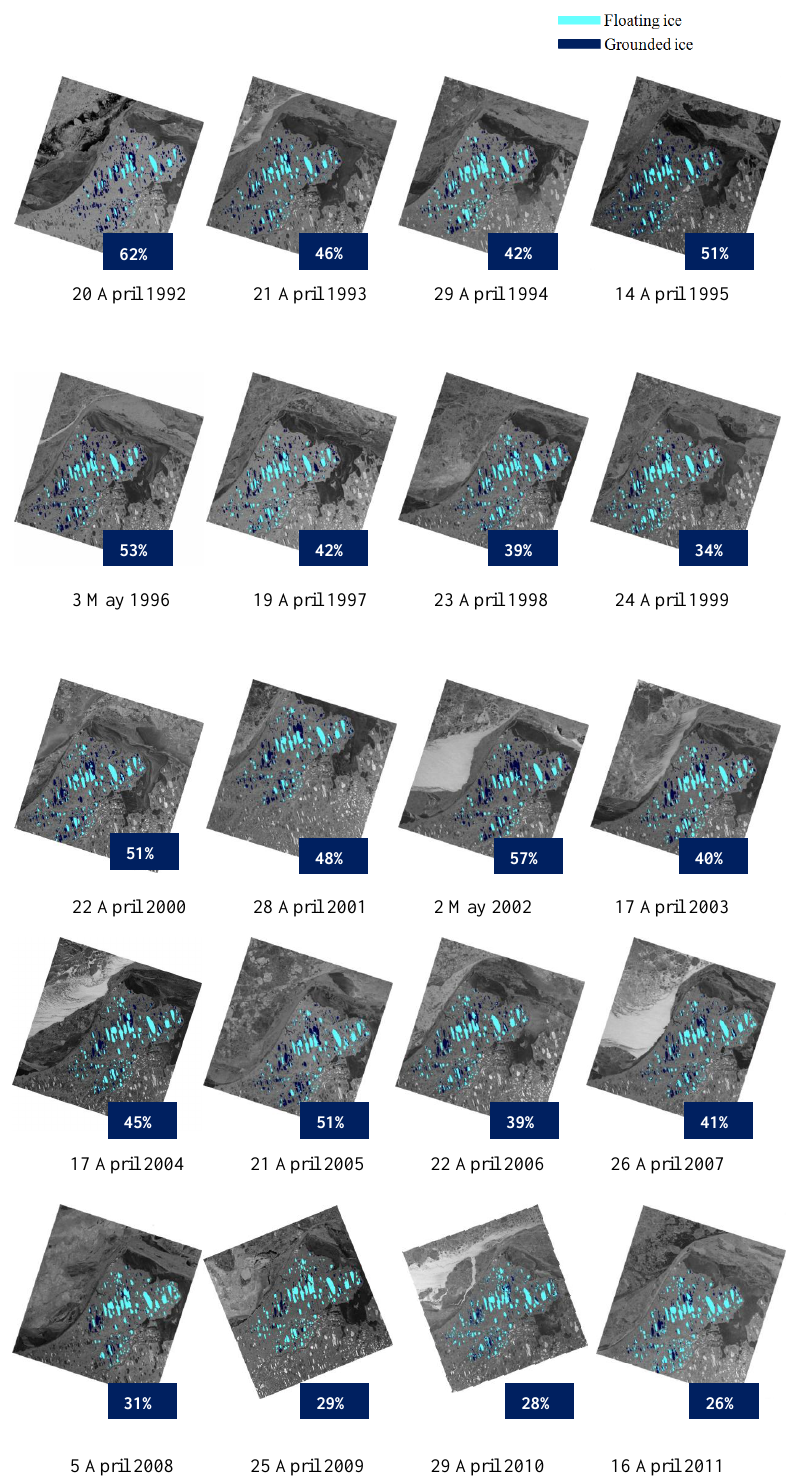
Fig. 3. Image segmentation results of ERS-1 / 2 SAR images acquired near the time of maximum ice thickness for lakes near Barrow, from 1992 to 2011. The fraction of grounded ice for each date is also shown. Data source: Alaska Satellite Facility. All SAR images are copyright ESA (1992-2011).